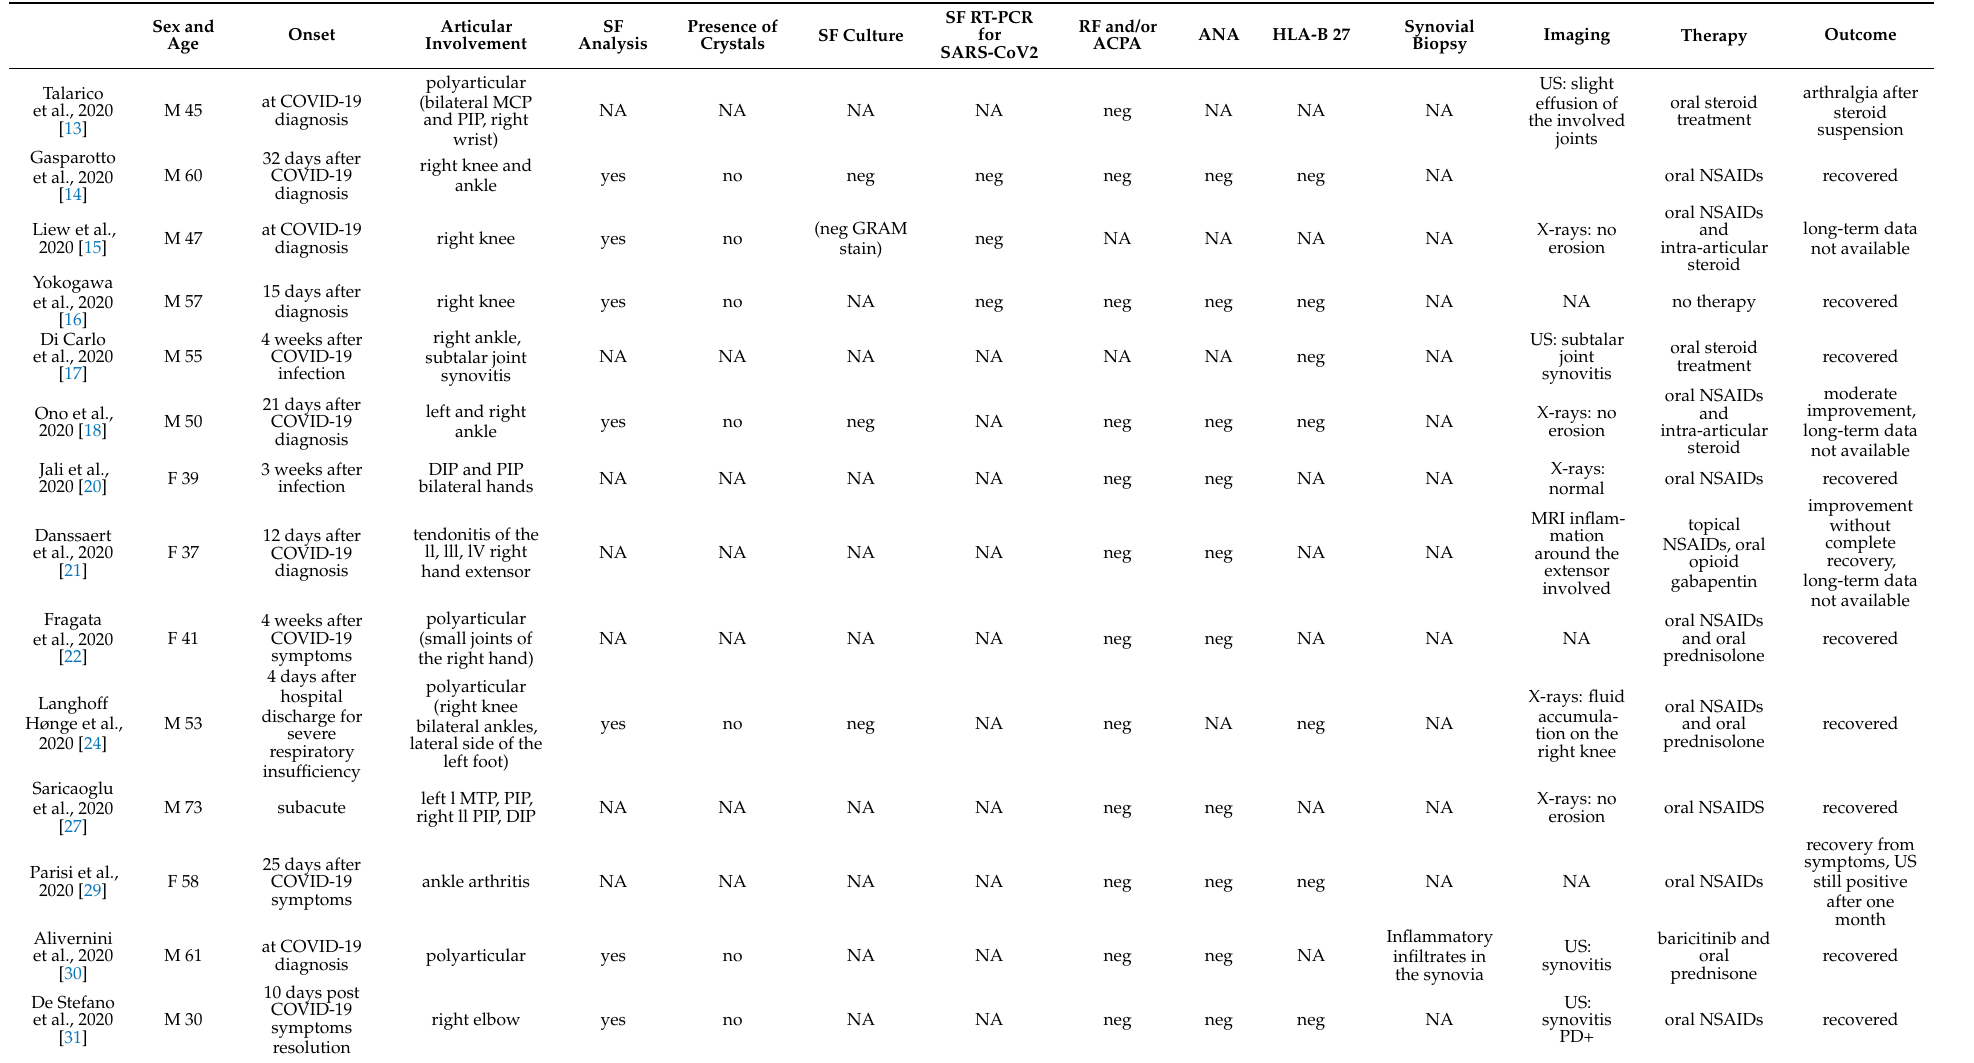
Table 3. Case reports of SARS-CoV-2-related